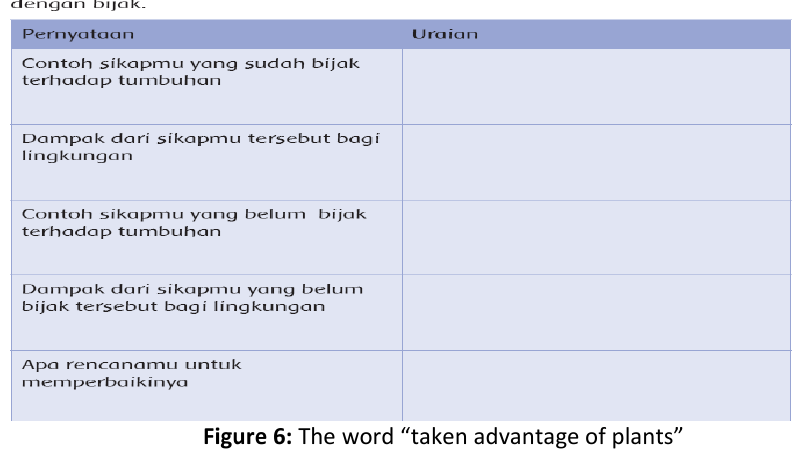
Figure 6: The word “taken advantage of plants”